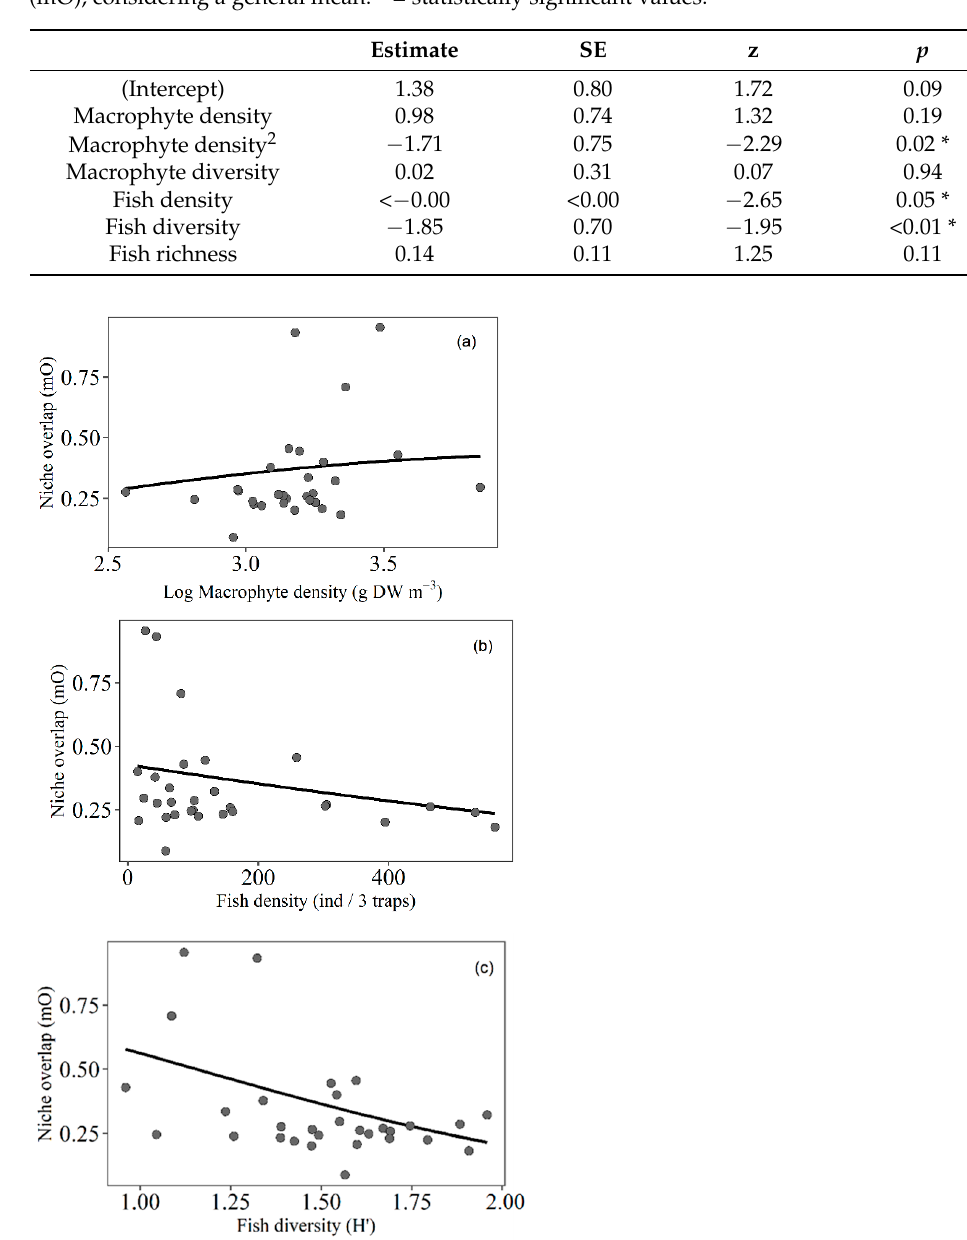
Figure 4. Trophic niche breadth, assessed by the mean of the distance from the centroid (mDC) considering a general mean ( a , c , e —gray dots) and a mean calculated for each trophic guild sepa- rately ( b , d , f —colorful dots), related to the variables with a significant effect for some of the trophic guilds or for the general mean in the performed beta regression. Dashed lines represent non-signif- icant models. Note that log scale was used for macrophyte density.